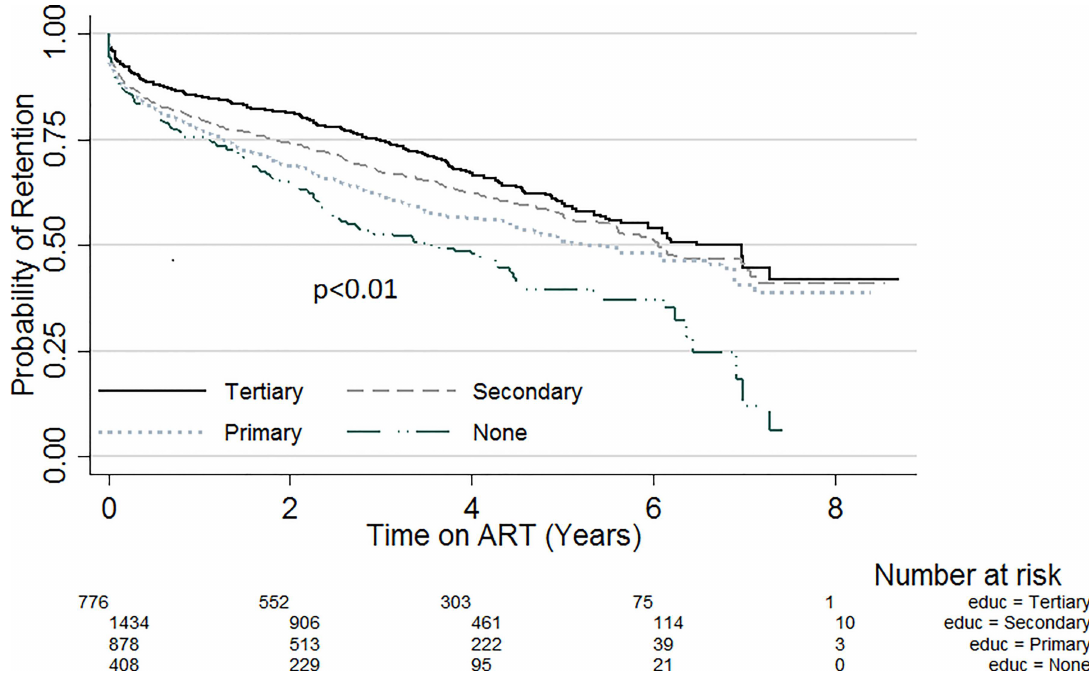
Fig 3. ART retention by level of education.